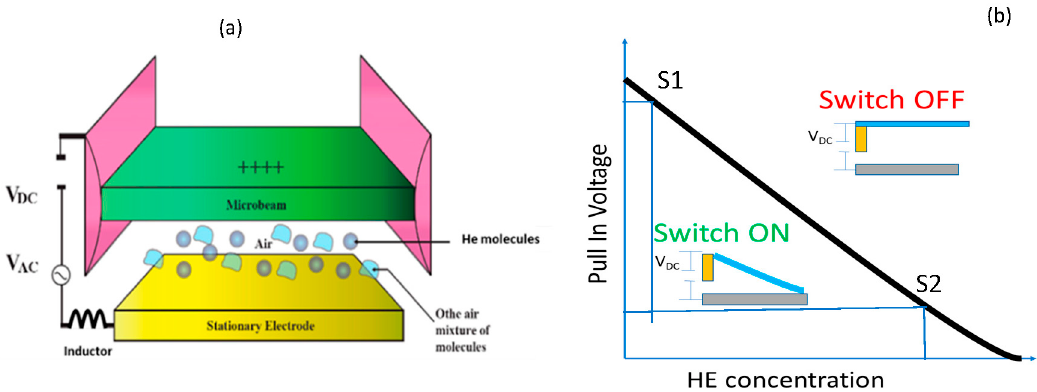
Figure 1. The operation concept of the proposed helium switch. ( a ) A schematic view of a parallel plate cantilever capacitor and ( b ) the switch operation curve, any point above the curve leads to the switch opening a circuit. The switch can be tuned to be triggered OFF at different helium concentrations by changing the bias voltage.